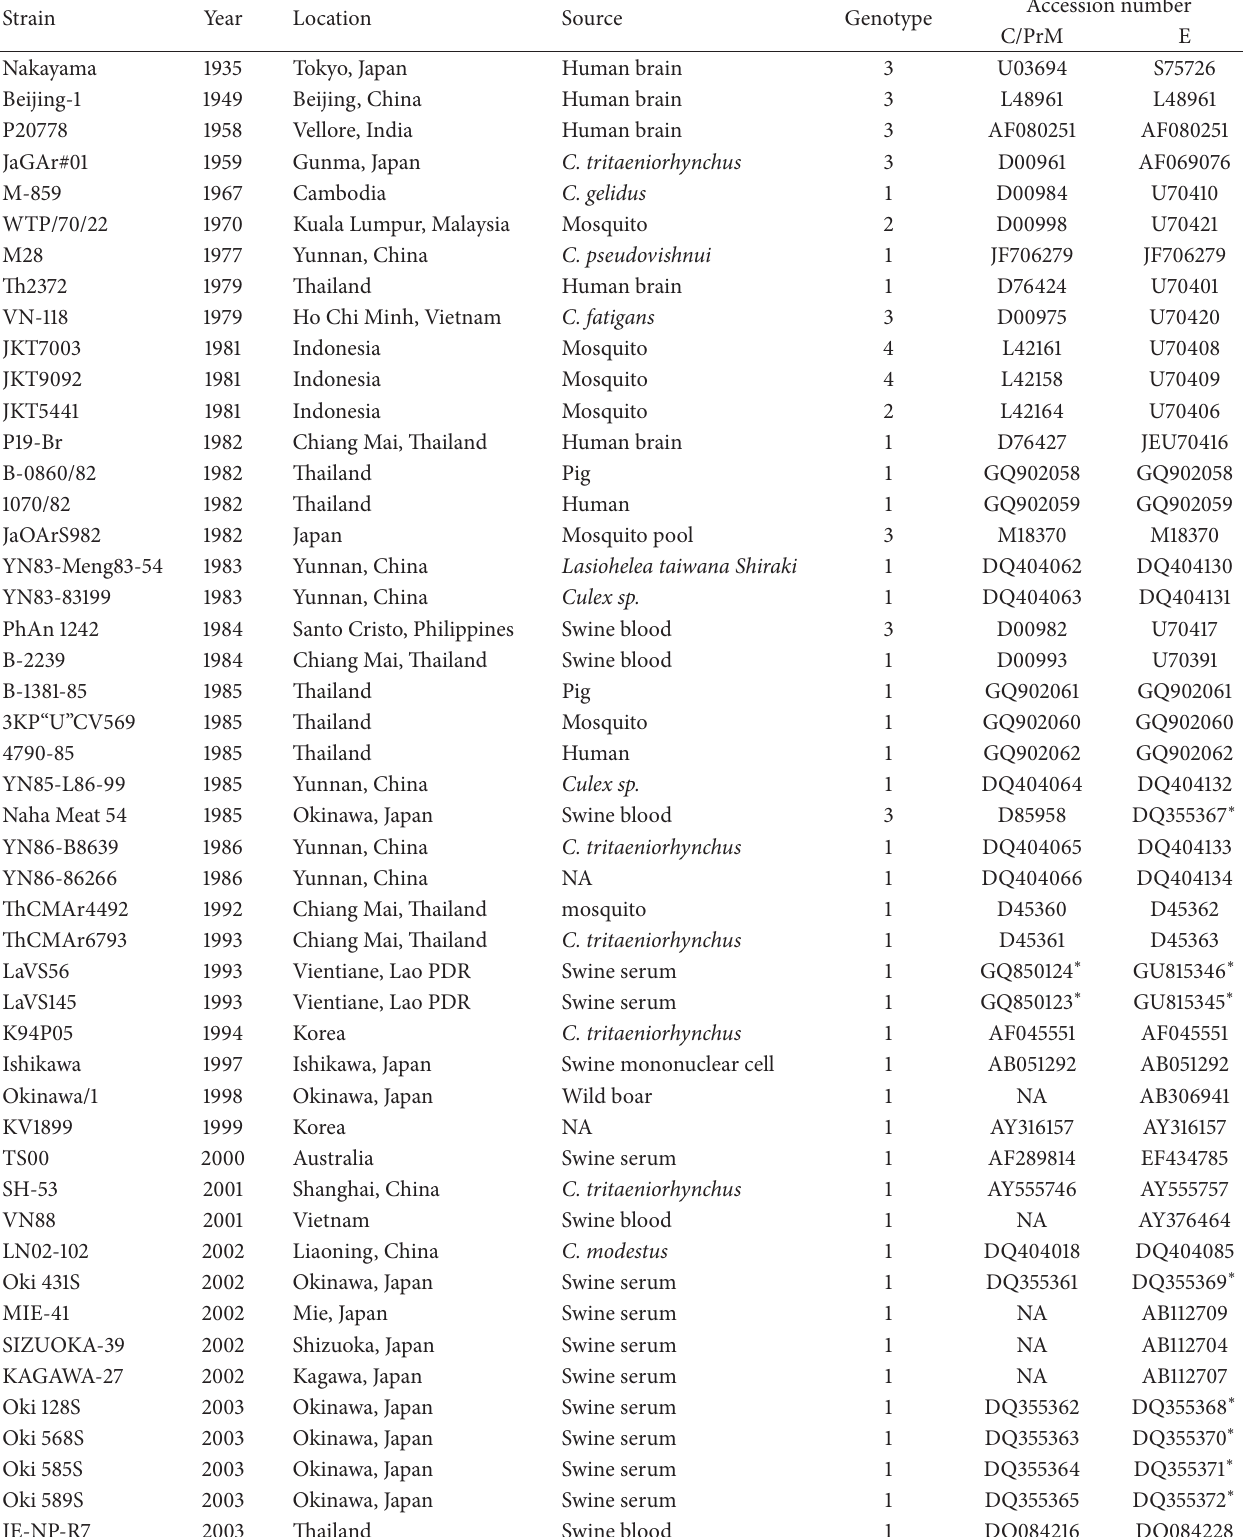
Table 1: JEV isolates analyzed in this